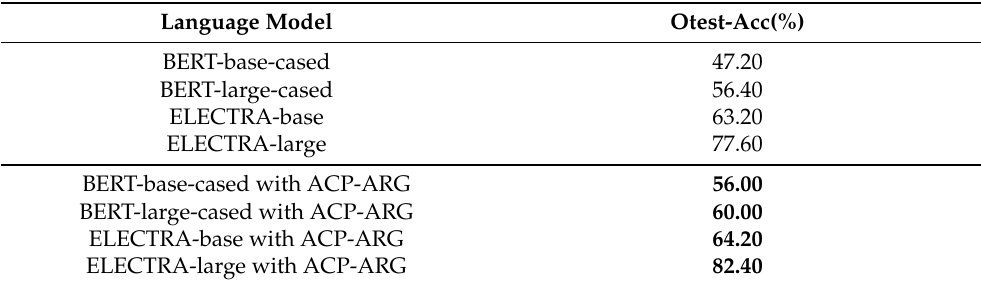
Table 6. OpenBook QA results on BERT and ELECTRA